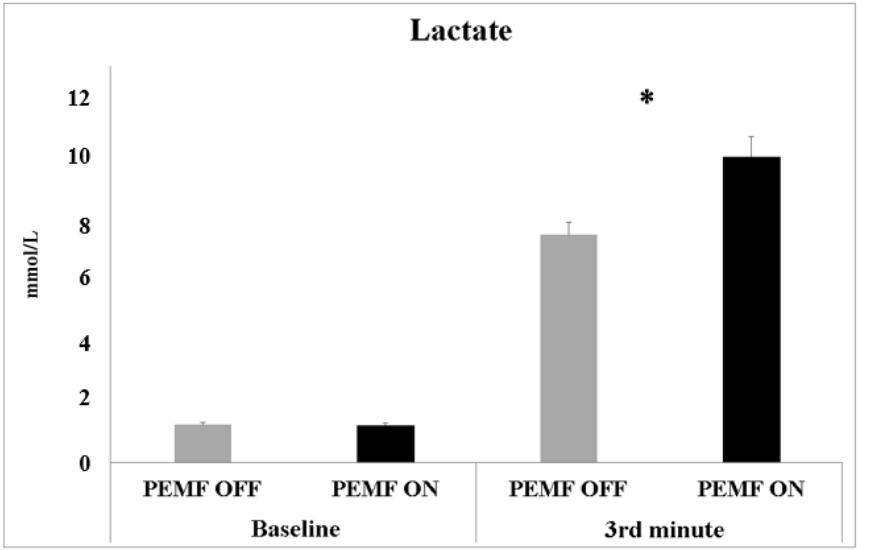
Figure 4. Blood lactate concentrations measured before the beginning of the experiment (baseline) and at 3rd min of constant-load physical effort of both PEMF ON and OFF stimulation. Data are shown as mean values ± SE. Asterisks indicate significant values at p < 0.05.